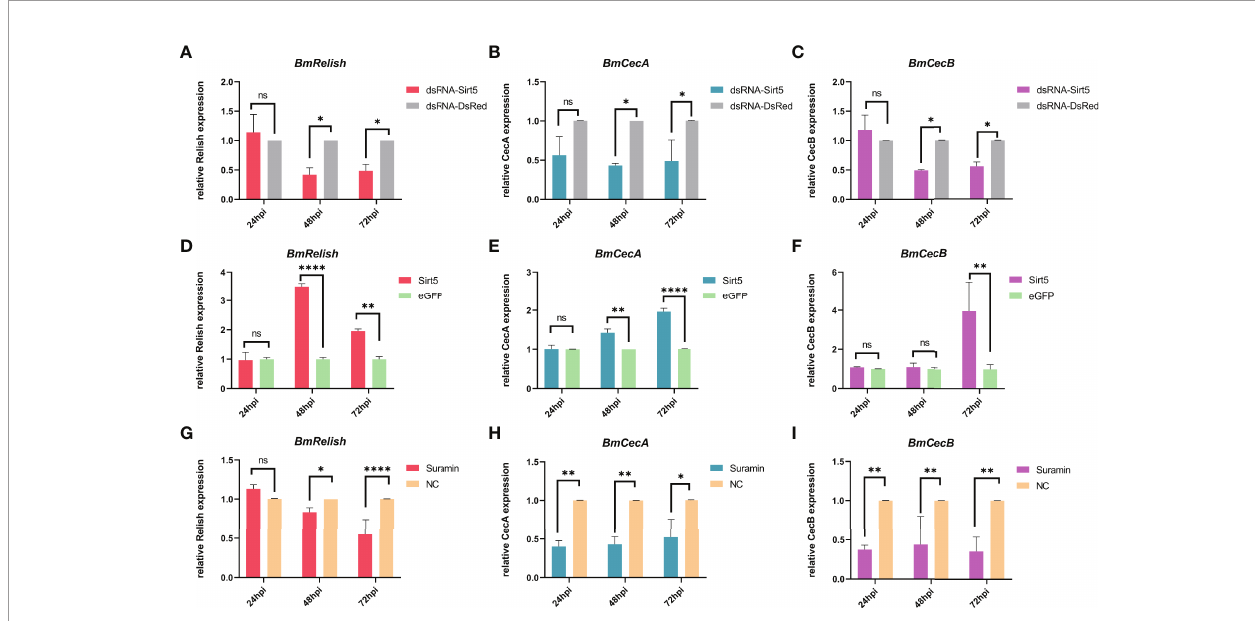
FIGURE 8 | Enhancement of BmRelish-mediated immunity by BmSirt5 during BmNPV infection. (A – C) Quanti fi cation of the expression of BmRelish , CecA and CecB by qRT-PCR after knockdown of BmSirt 5 in BmN cells at 24, 48 and 72 h after BmNPV infection. BmN cells treated with dsRNA-DsRed were used as negative control. (D – F) Quanti fi cation of the expression of BmRelish , CecA and CecB by qRT-PCR after over-expression of BmSirt5 in BmN cells at 24, 48 and 72 hpi. BmN cells treated with pIEX-eGFP were used as negative control. (G – I) Quanti fi cation of the expression of BmRelish , CecA and CecB by qRT-PCR after treatment with Suramin in BmN cells. BmN cells treated with ddH 2 O were used as negative control. Each bar represents the mean ± SD. *p < 0.05, **p < 0.01, ****p < 0.0001. ns, not signi fi